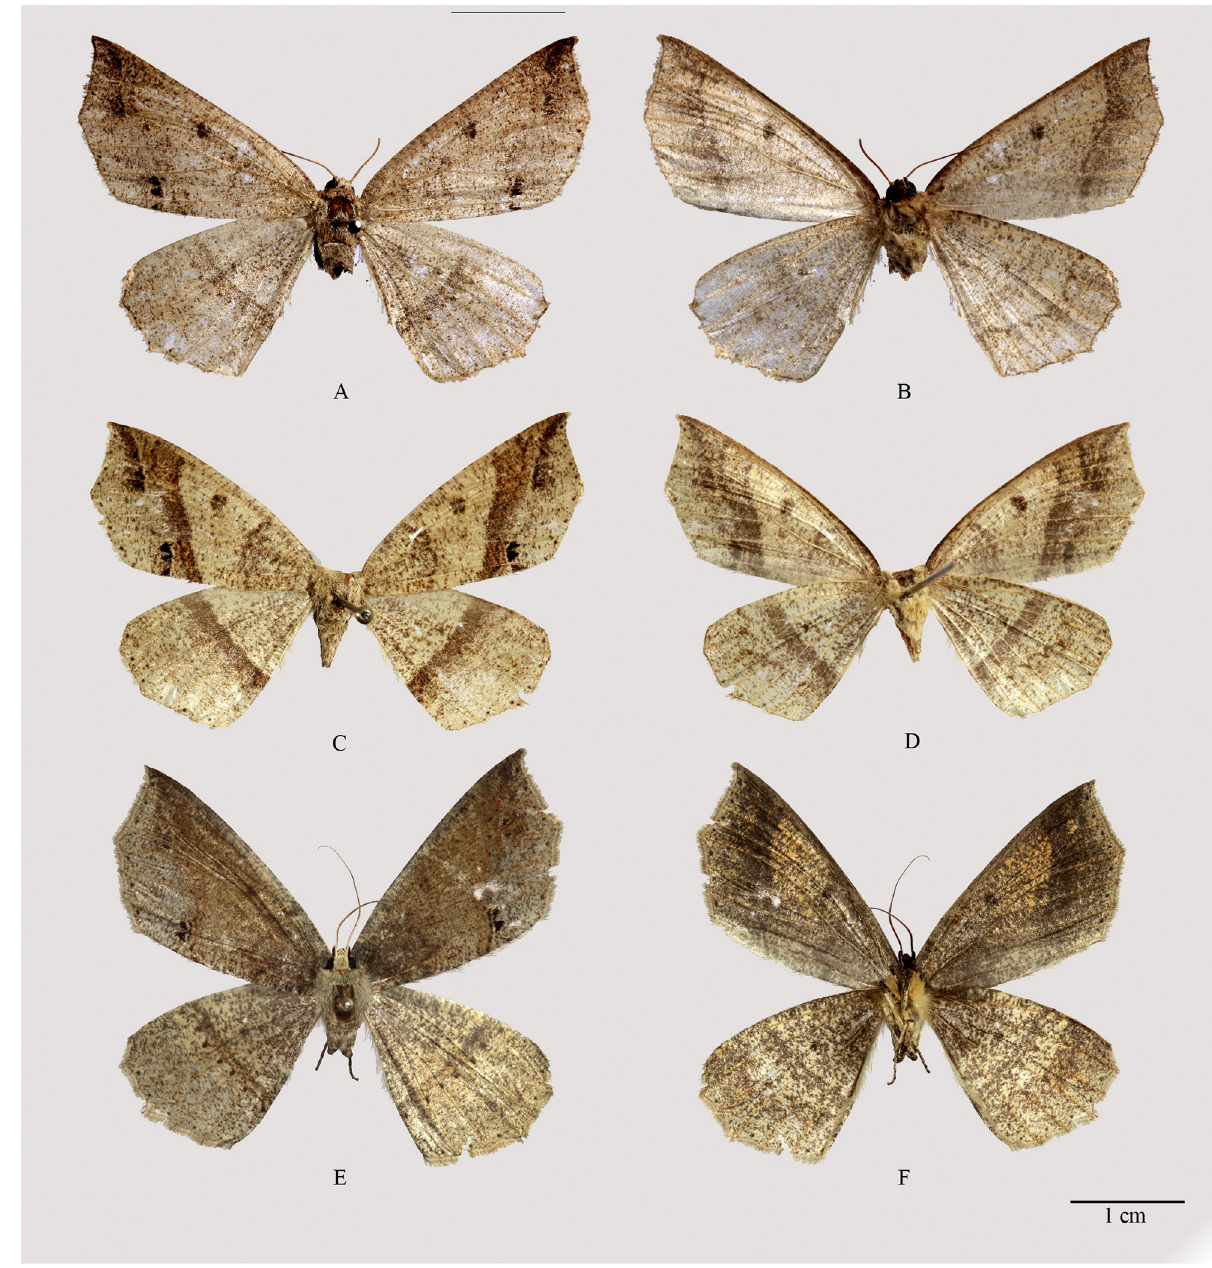
Fig 11. Habitus of Psyra variabilis . A. Holotype of P . variabilis ♂ B. Holotype of P . variabilis ♂ underside C. Paratype of P . variabilis ♂ from Uttarakhand D. Paratype of P . variabilis ♂ underside from Uttarakhand E. Paratype of P . variabilis ♂ from Sikkim F. Paratype of P . variabilis ♂ underside from